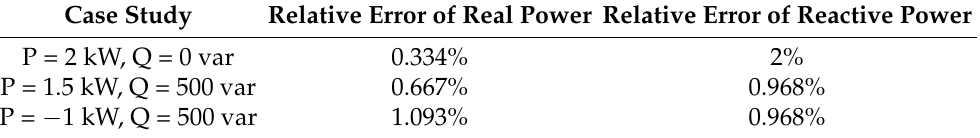
Table 2. Relative error